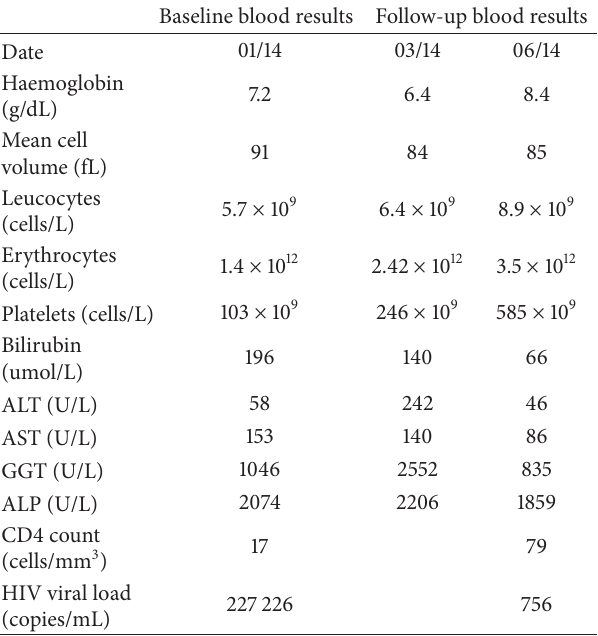
Table 1: Showing baseline and follow-up blood results. Baseline blood results Follow-up blood results